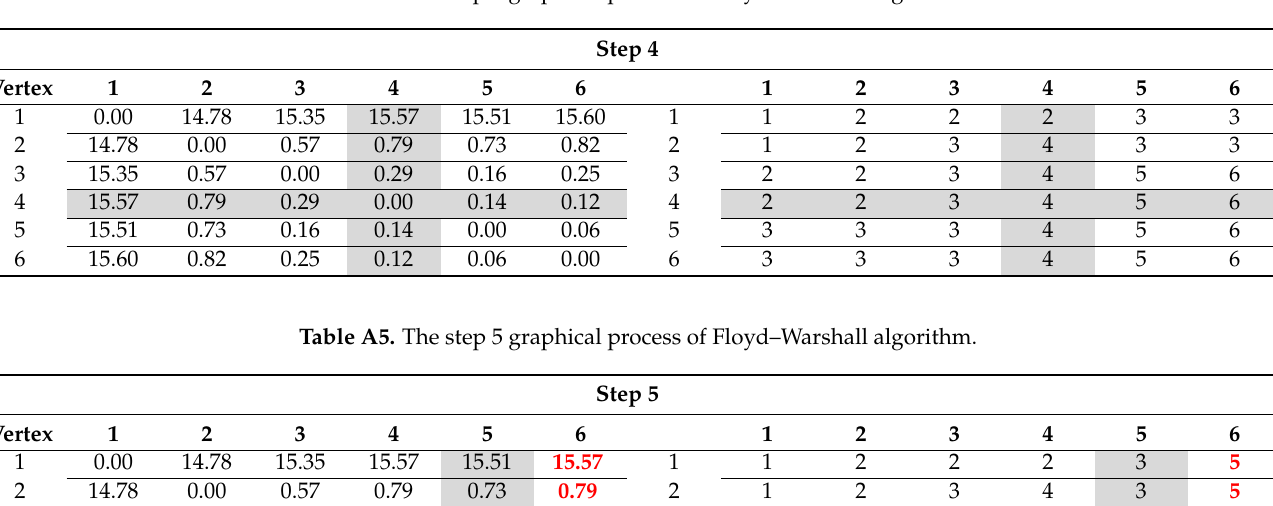
Table A4. The step 4 graphical process of Floyd–Warshall algorithm.